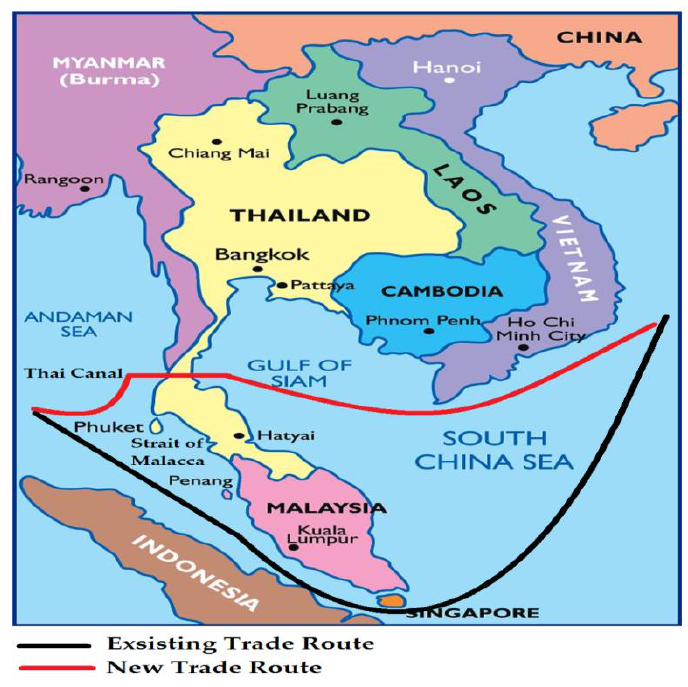
Figure 1: Existing and new trade route to/from east and